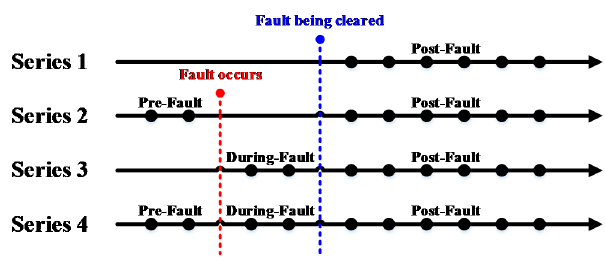
Figure 2. Di ff erent sampling Figure 2. Different sampling series. Figure 2. Different sampling series.